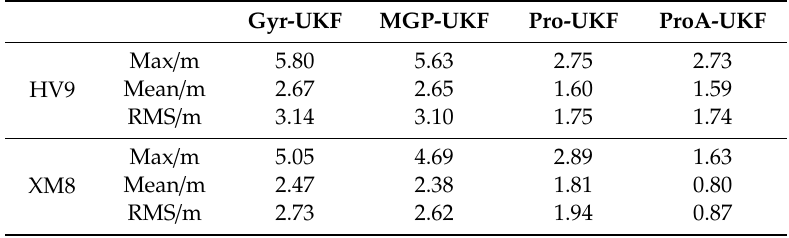
Table 3. Statistics of position error with di ff erent method for di ff erent